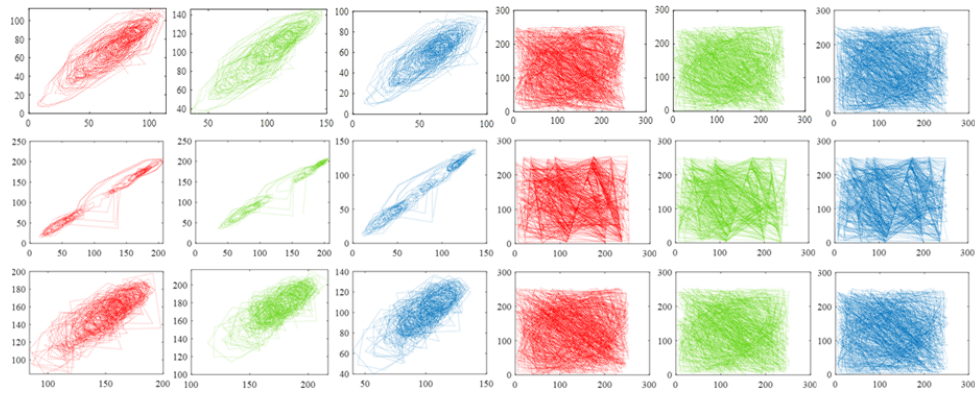
Figure 8. Correlation values of adjacent pixels of image llama. The first, second, and third columns are drawn based on adjacent pixels from the red, green, and blue channels of the original image, and the fourth, fifth, and sixth columns are drawn based on adjacent pixels of signal Y c . The three rows show the results calculated from horizontal, vertical, and diagonal directions, respectively. The compression rate is 0.7.